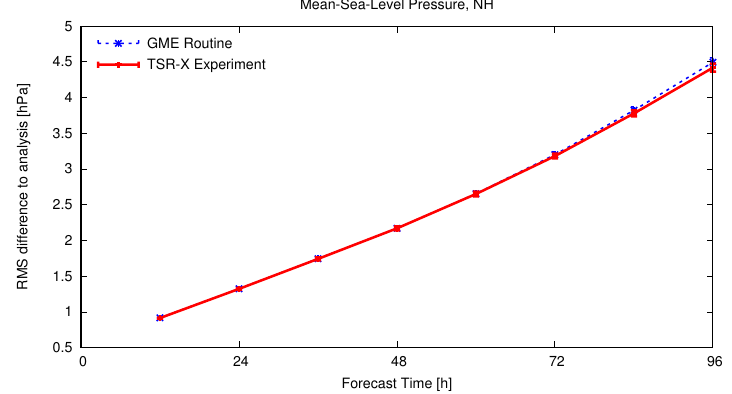
Fig. 7. The RMS difference of mean-sea-level pressure as a function of forecast time in the Northern Hemisphere for the operational routine (dashed blue line) and the experiment including GPSRO data from TerraSAR-X (thick red line). The statistics is based on 56 forecasts (00Z and 12Z) corresponding to 28 days of data (22 October–18 November 2010). The error bars give a rough indication of the uncertainty of the mean as estimated from the time series of the RMS differences. The comparisons are performed against each experiment’s own